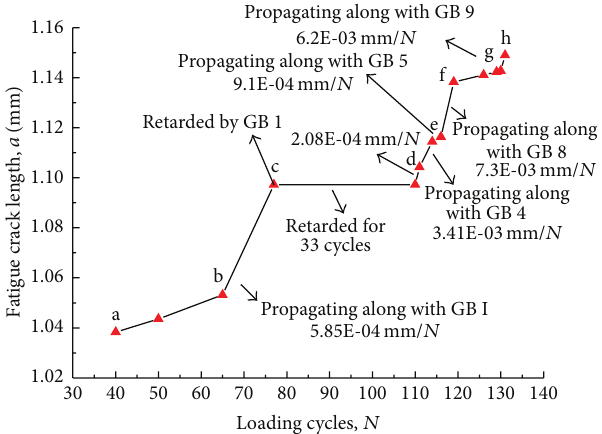
Figure 11: Increment of fatigue crack length with the change of loading